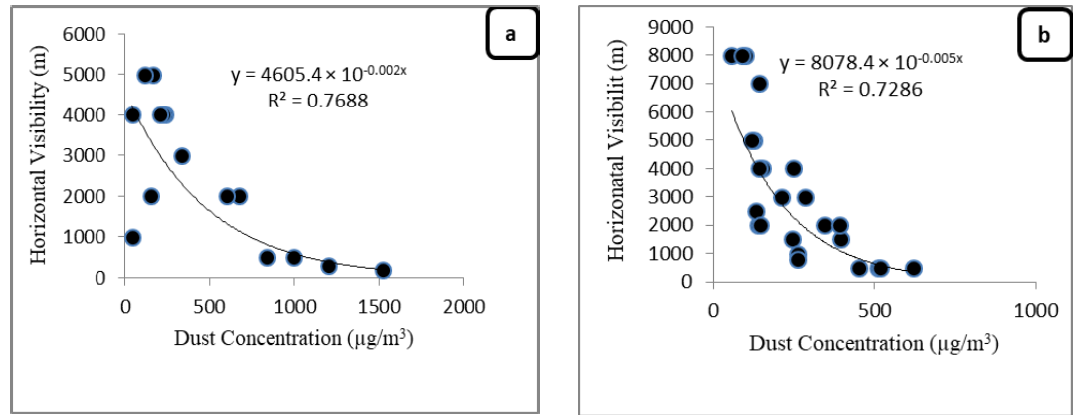
Figure 14. Correlation of Simulated Surface Dust Concentration Using GOCART Scheme with Horizontal visibility of Synoptic Stations in Storms 14 February 2018 ( a ) and 21 February 2015 ( b ).